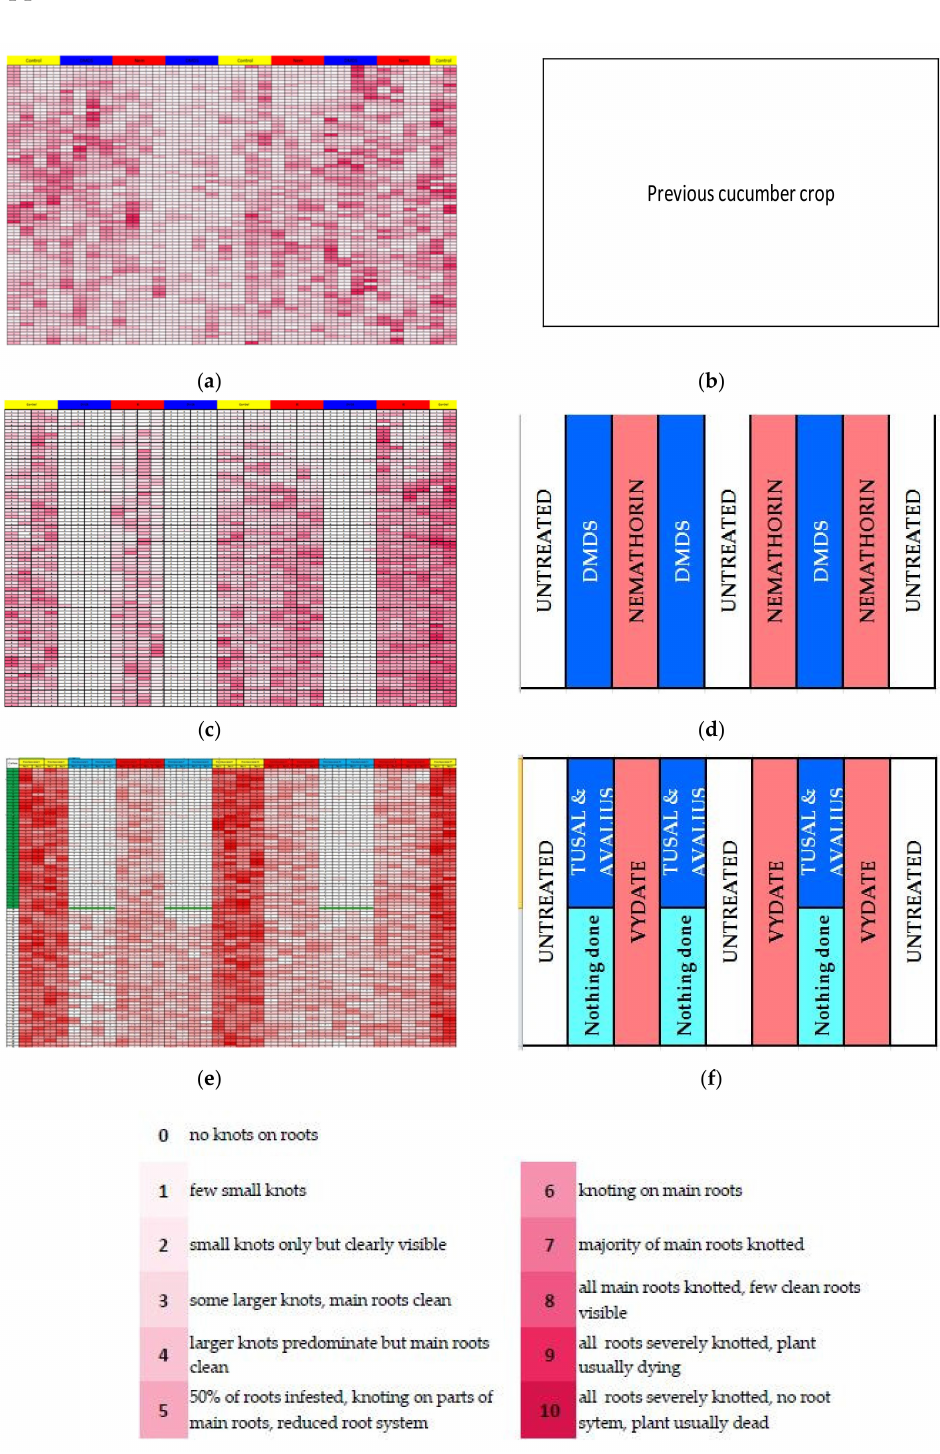
Figure A1. Map of Meloidogyne spp. root-knot infestation level (estimated according to Bridge and Page [14] rating scale of root-galling) and schemes of respective experimental plots. ( a ) Root mapping before starting the trial (previous crop), ( b ) Plot selected for the trial. ( c ) Root mapping at the end of first crop. ( d ) Scheme of the trial at first cucumber crop. ( e ) Root mapping at the end of second crop. ( f ) Scheme of the trial at second cucumber